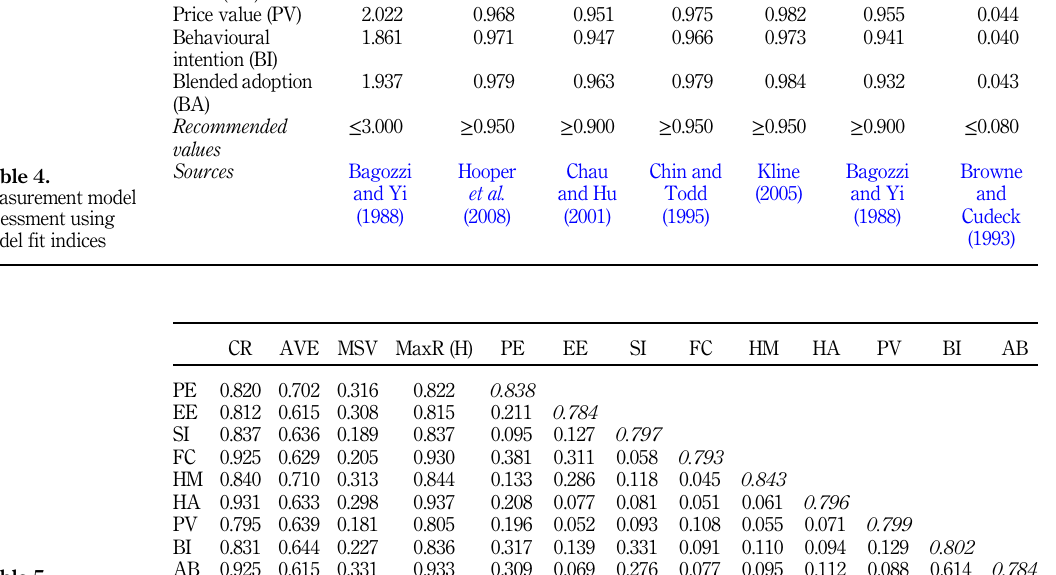
Table 5. Measurement of discriminant